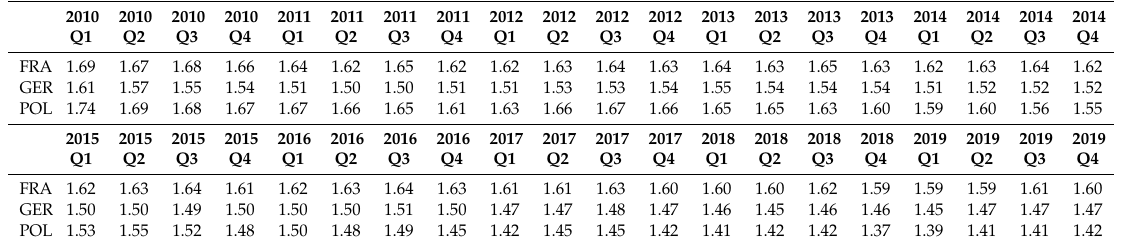
Table 9. Export multiplier, own work, source: Eurostat.